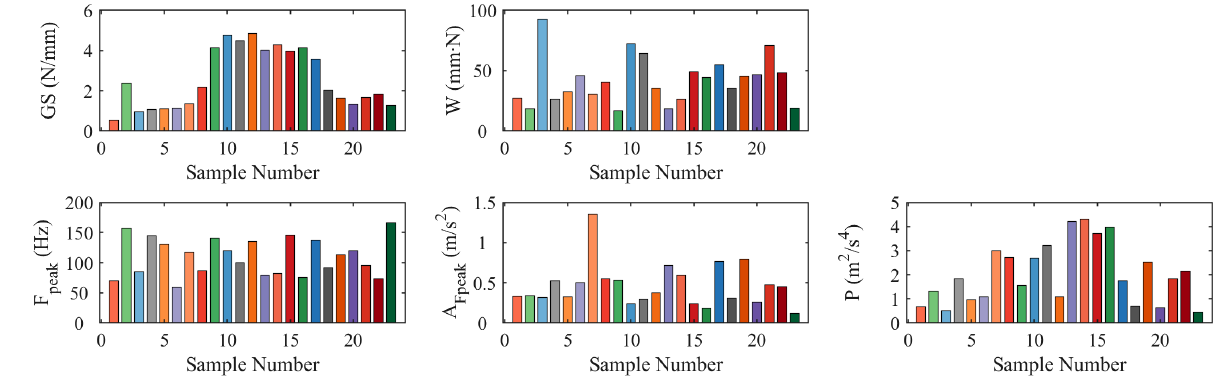
Figure 8. The best individual chromosome obtained by GA of the twenty-three